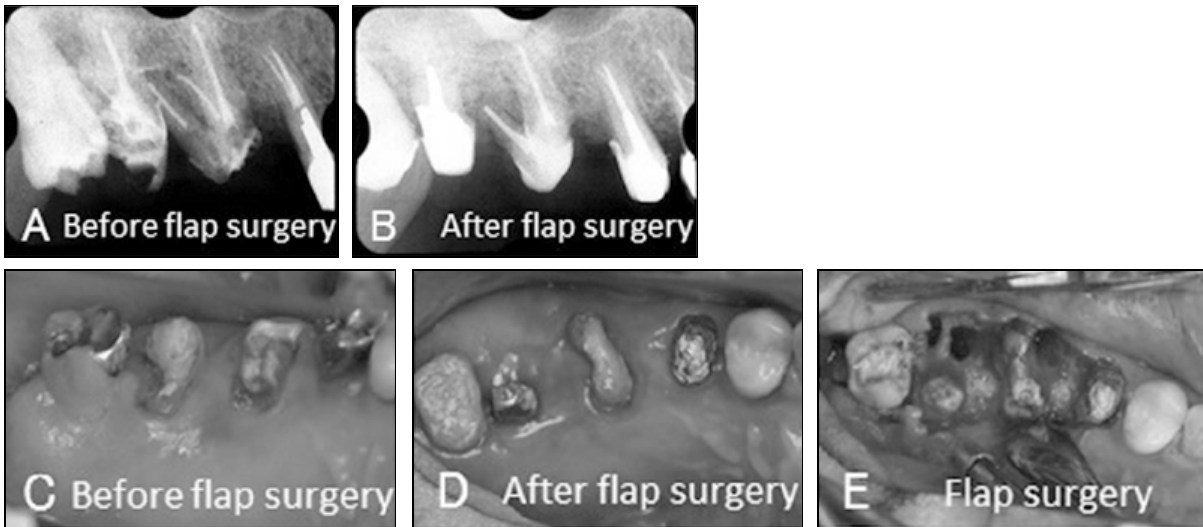
Figure 3. Periapical radiographs and clinical photographs before and after periodontal flap operation. A & C: before the surgery. E: during the surgery. B & D: after the surgery.